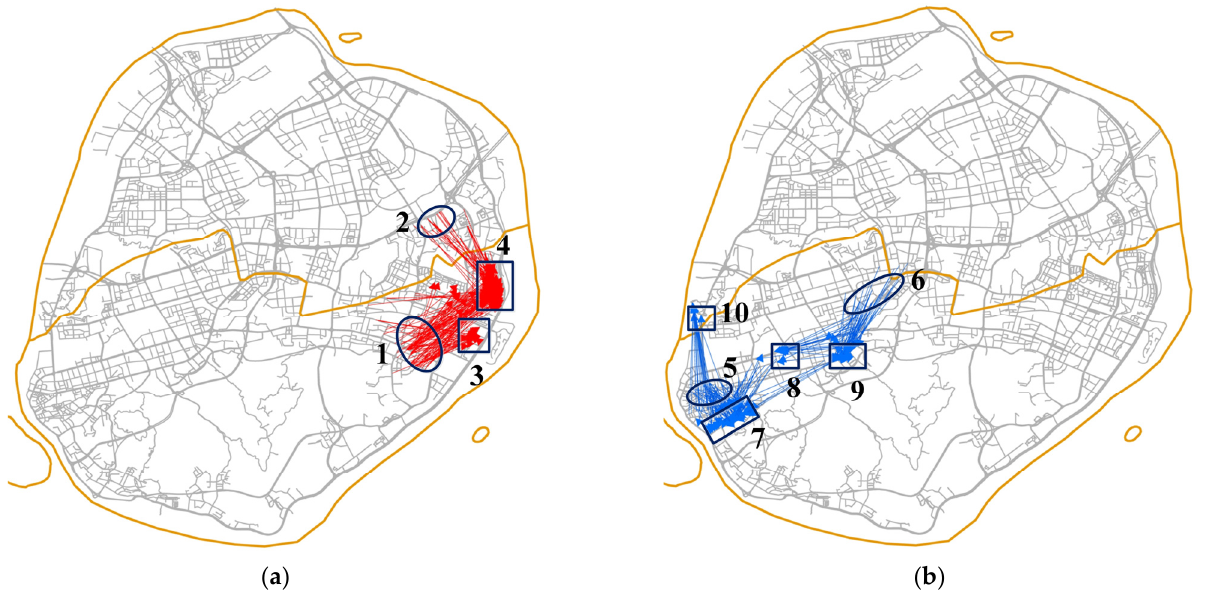
Figure 11. Example flows that exhibit strong spatial associations: ( a ) taxi; ( b ) ride-hailing.